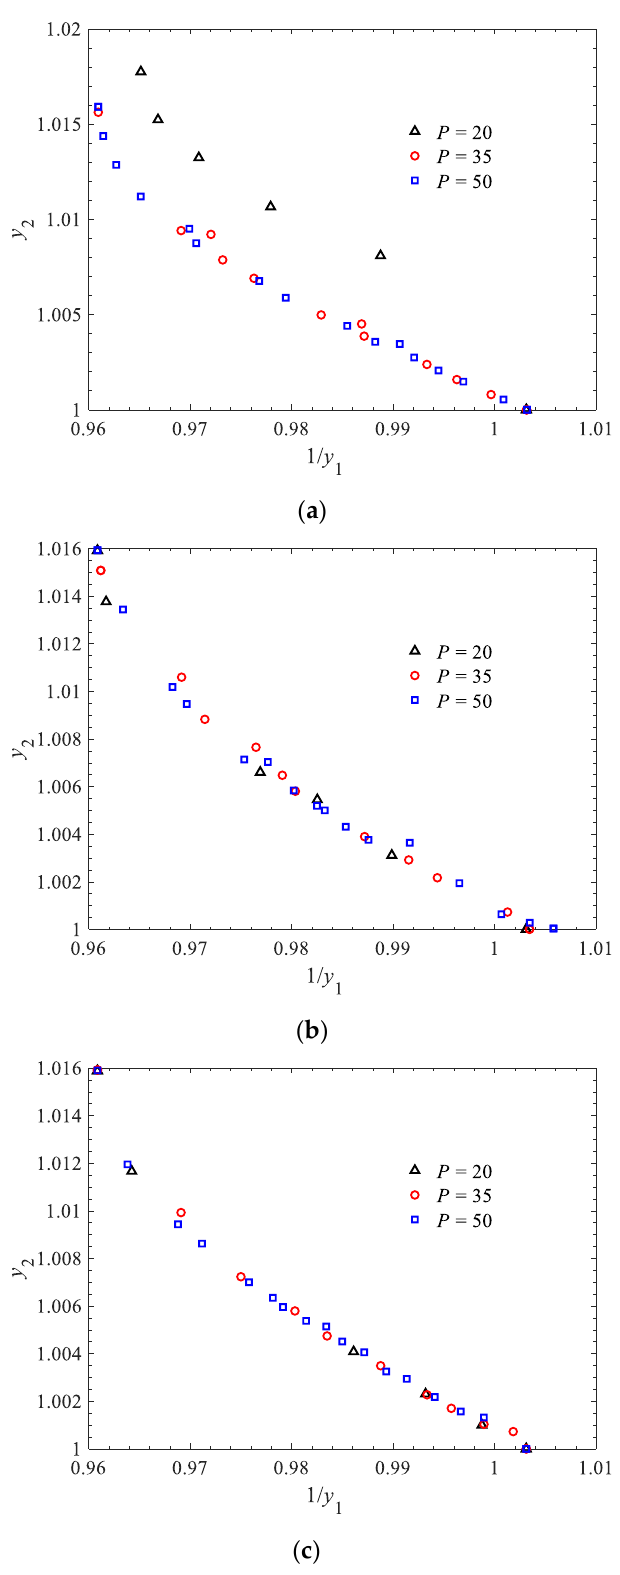
= 200; ( b ) G = 300; ( c ) G =